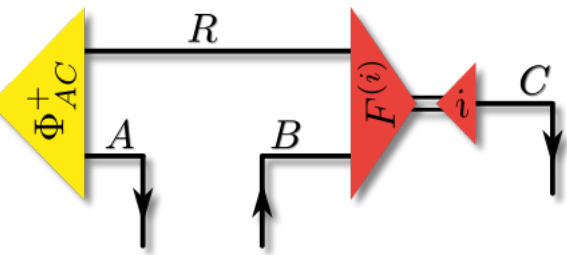
Figure 6: Measurement in entangled basis. The map L measures the state on ⊗ H ) in the Bell basis and feeds forward 0 if the result corresponds to Φ + B ( H B R and 1 otherwise. If Charlie measures in the computational basis, conditioned on his outcome, Alice and Bob share a channel that can transmit quantum information (for outcome 0) or not (for outcome 1) from Bob to